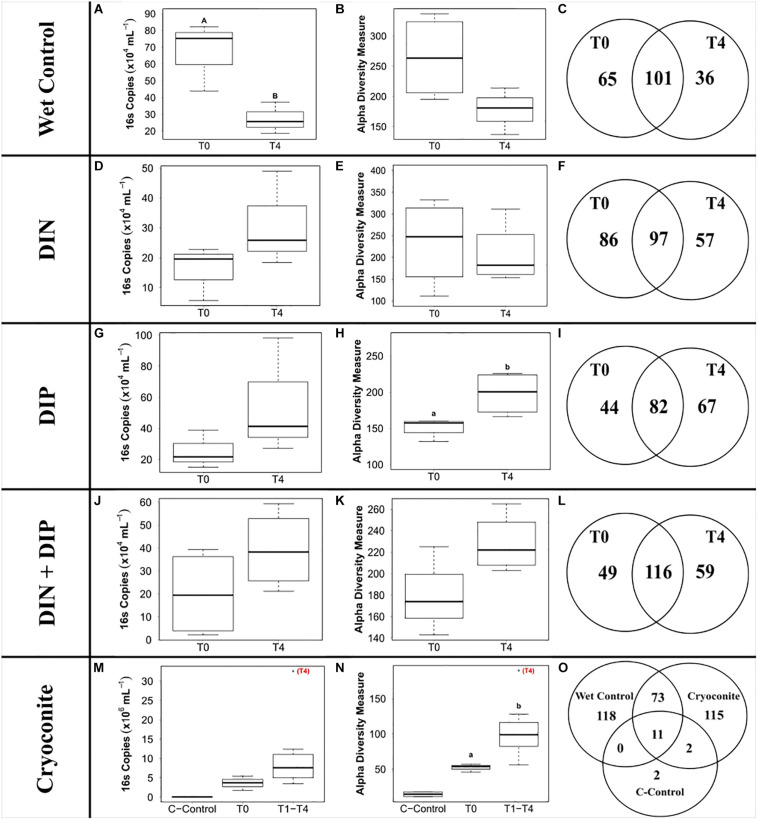
Boxplots showing the median, upper and lower interquartile range of bacterial abundance (A,D,G,J,M) and observed Alpha diversity measurement (B,E,H,K,N) and Venn diagrams depicting genera richness (C,F,I,L,O) for all treatments. T0 and T4 represent initial and final time point, respectively. C-Control in the cryoconite treatment represents untreated, furnaced cryoconite control. DIN and DIP represent dissolved inorganic nitrogen and dissolved inorganic phosphorus, respectively. Uppercase letters denote homogeneous subsets derived from post hoc Tukey HSD analysis on a significant two-way ANOVA in relation to treatment and time point. Lowercase letters denote t-test comparisons in relation to time point.